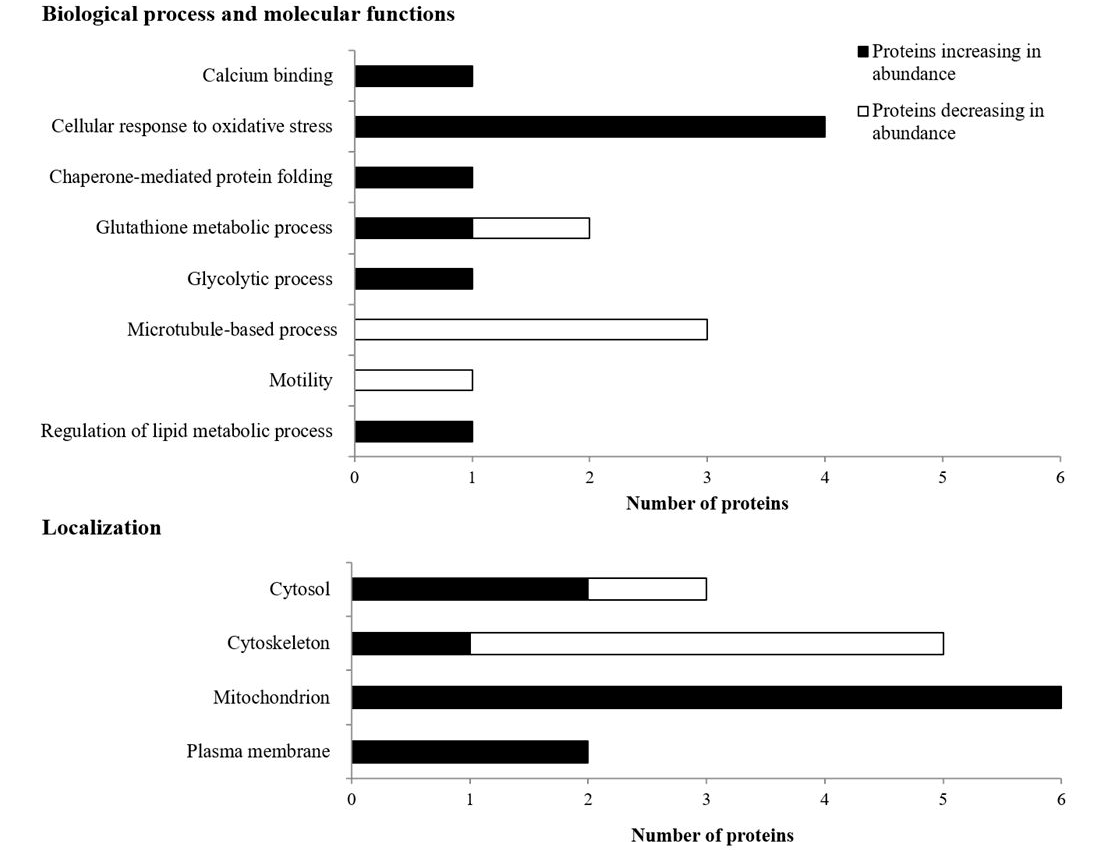
Figure 3. A graph representing number of identified thawed bull spermatozoa proteins from young involved in different biological processes and molecular functions, as well as their cellular location. Black bars represent proteins increasing in abundance in adult bulls in comparison to young bulls, and white bars represent proteins decreasing in abundance in adult bulls in comparison to young bulls.